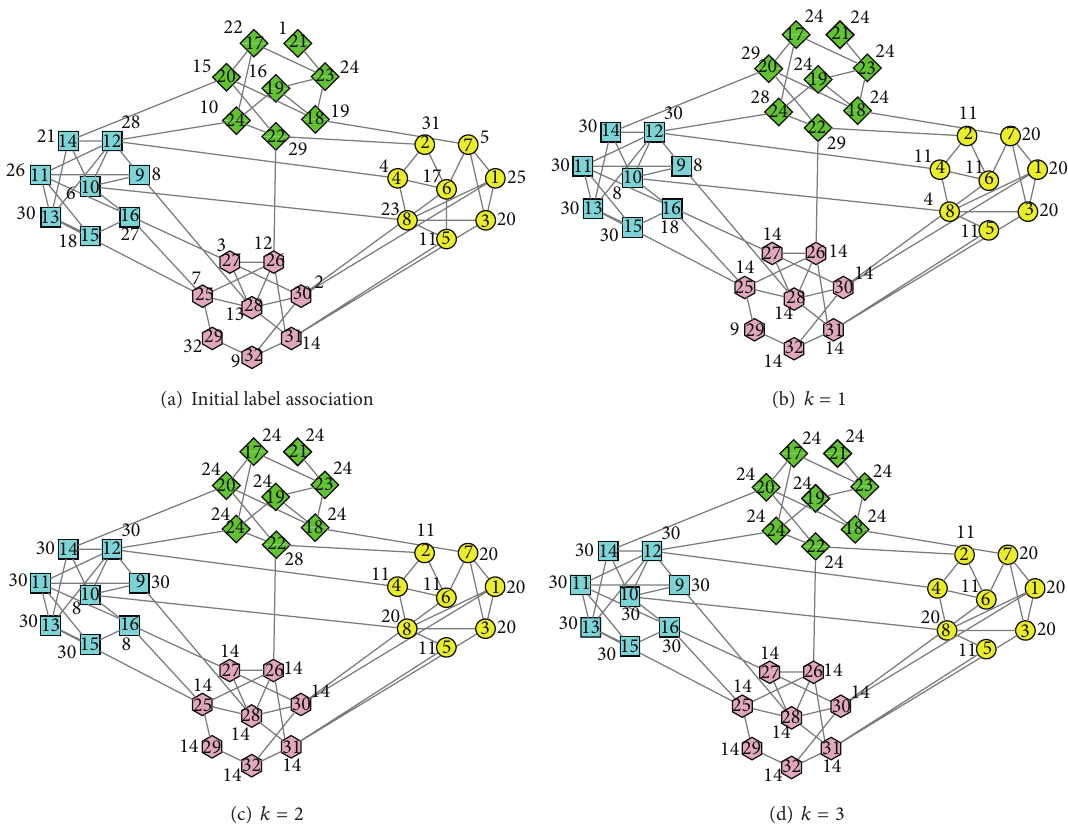
Figure 7: A community detection process on an unweighted computer-generated network using